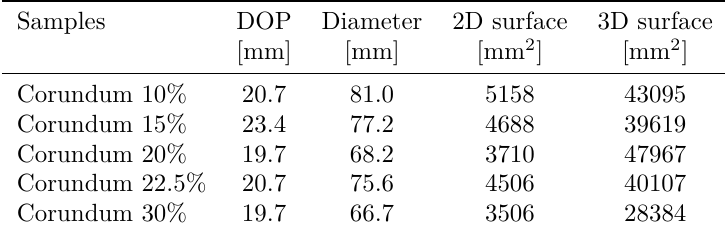
Table 4. Crater dimensions of UHPFRC after projectile impact.